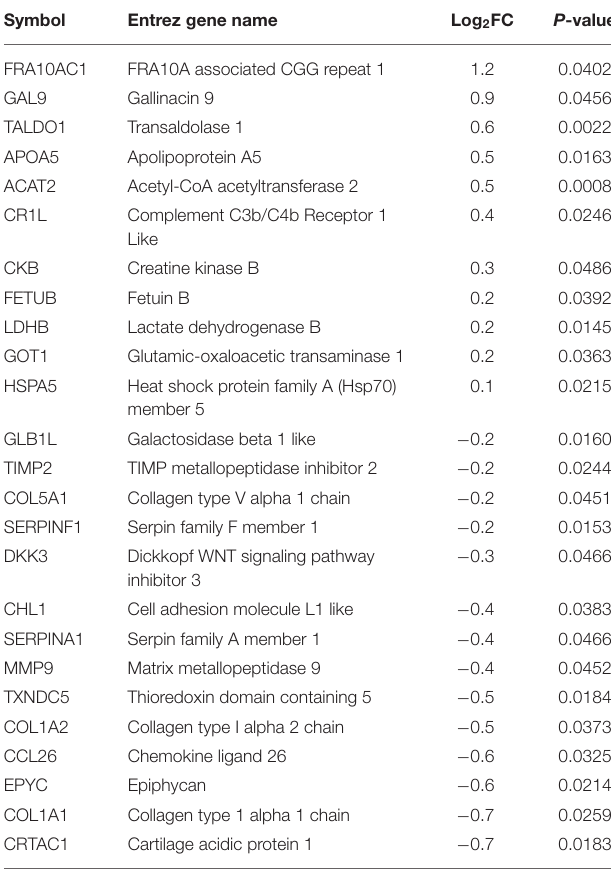
TABLE 1 | Plasma protein biomarkers in WB at 4 wks of age compared to